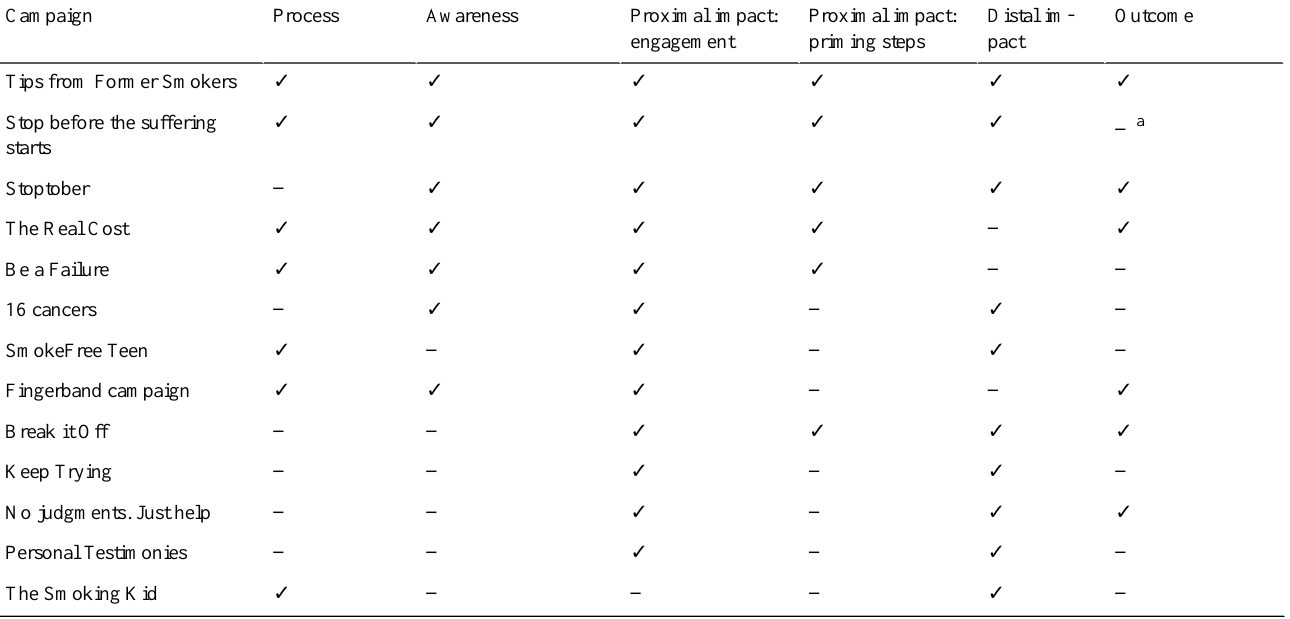
Table 2. Reported evaluation measures in behavioral change campaigns.